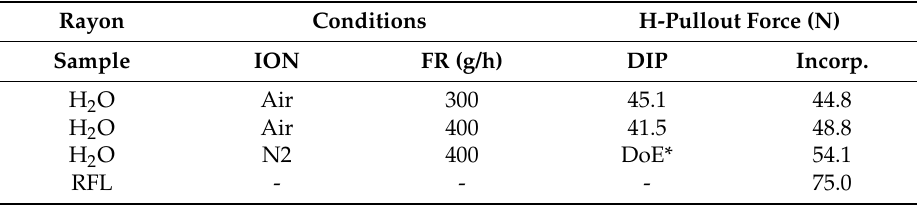
Table 5. H 2 O plasma-treated rayon cord.